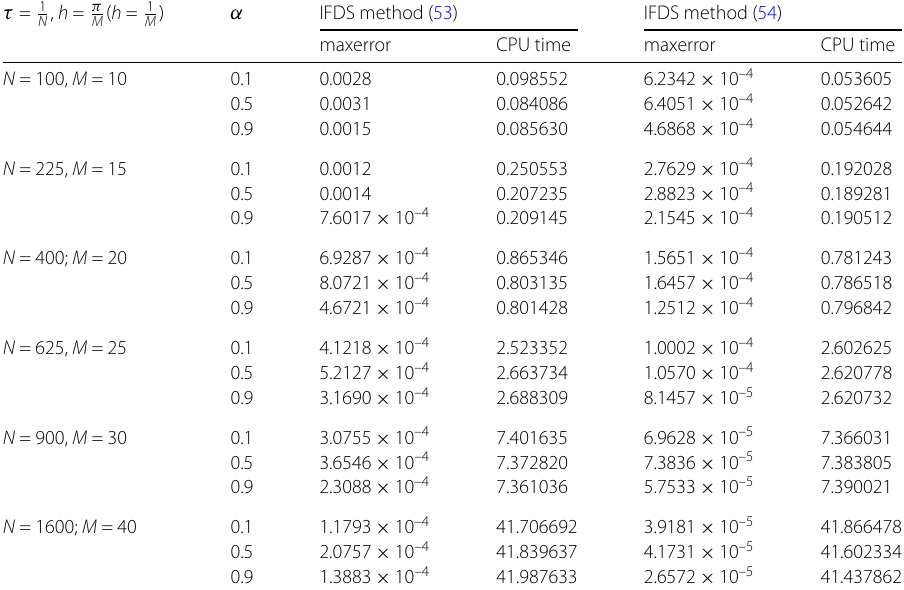
Table 1 First error analysis